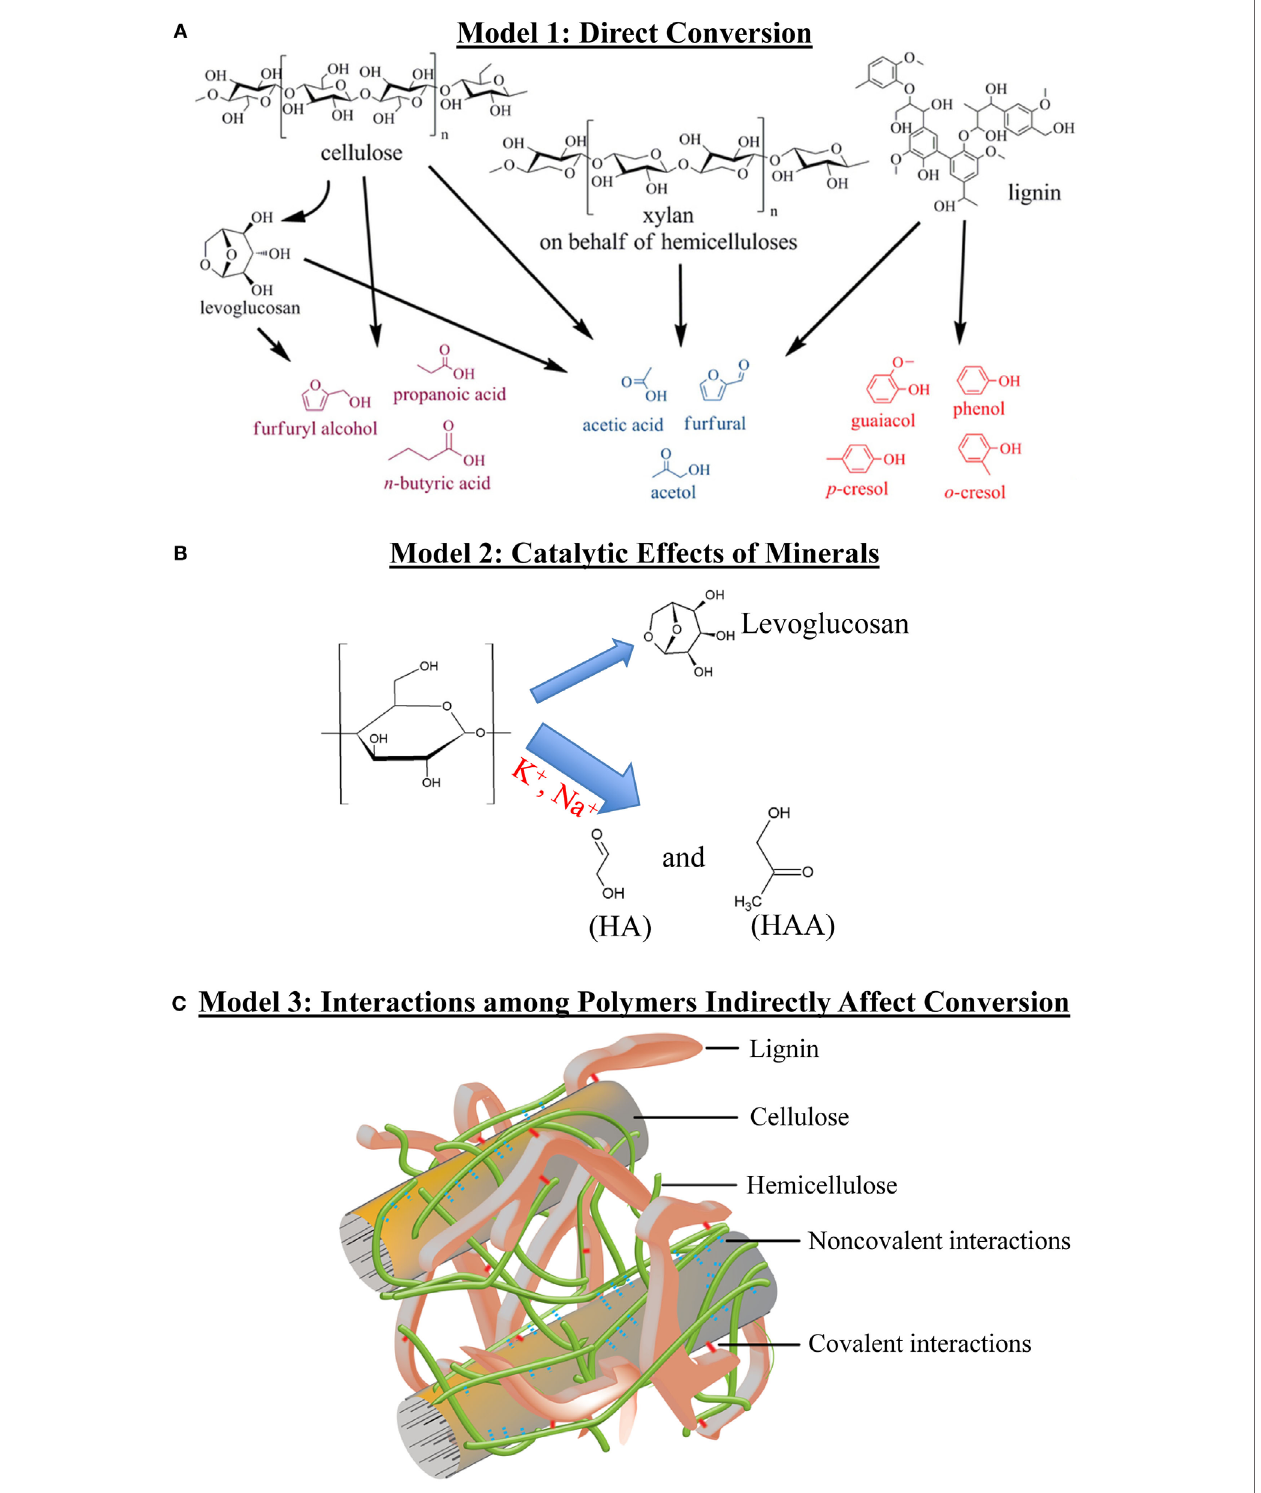
FiGURe 2 | Three models of how biomass components and their interactions affect the formation of thermal products . HA, hydroxyacetone; HAA, hydroxyacetaldehyde. (A) Direct conversion. (B) Catalytic effect of minerals. (C) Interactions among polymers indirectly affect conversion. (A) and (C) were adapted and modified with permission (Vanholme et al., 2010; Zhang et al.,